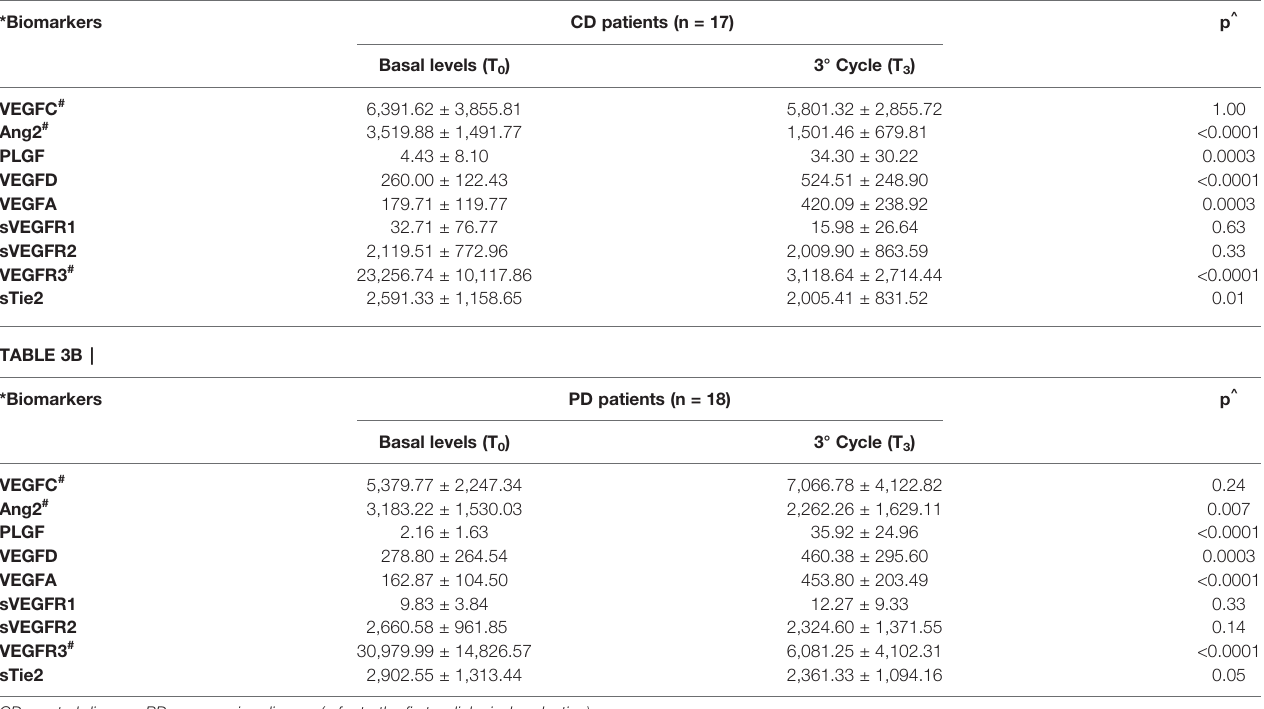
TABLE 3A | Trend of serological biomarkers at the fi rst radiological evaluation on patients with control ( A ) and progression disease ( B ).